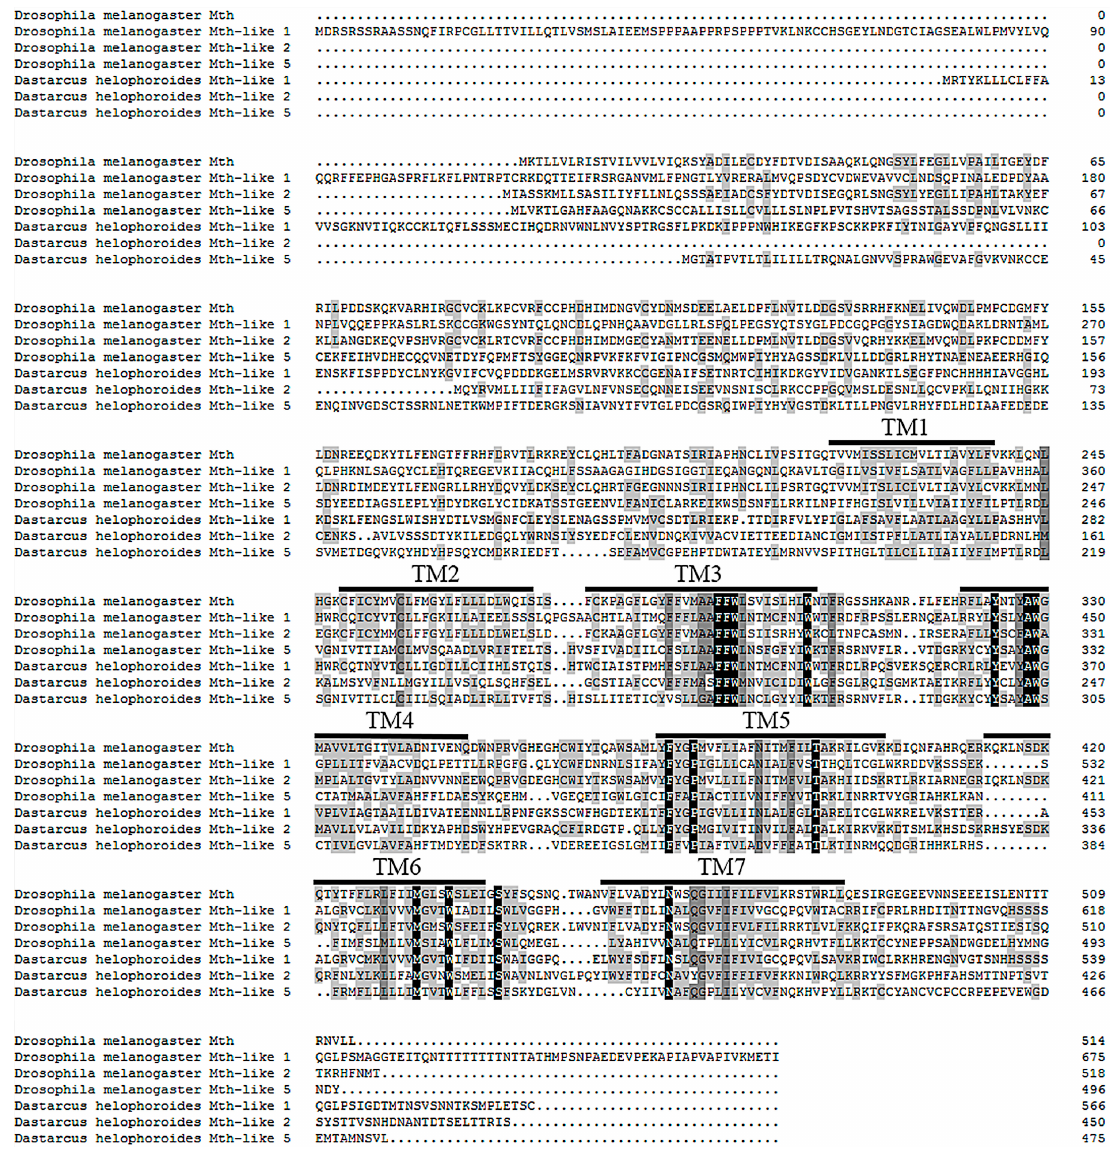
Figure 1. Sequence alignment of Mth/Mth ‐ likes. Sequences (cloned or annotated) are D. helophoroides Mth ‐ likes (Mth ‐ like1, Mth ‐ like2, and Mth ‐ like5), D. melanogaster Mth (NP ‐ 523871.1) and D. melanogaster Mth ‐ likes (Mth ‐ like1 NP ‐ 573140.1, Mth ‐ like2 NP ‐ 788462.2, and Mth ‐ like5 NP ‐ 650126.2). TM1–TM7 indicate the transmembrane domains. Identical or similar residues are highlighted black or grey, respectively, in the alignment. ORF: open reading frames.